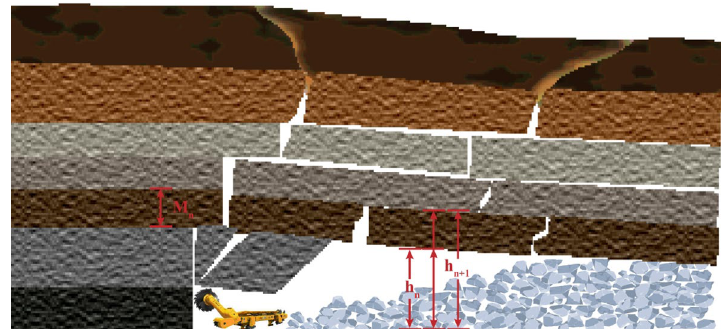
Figure 3. Diagram of overlying porosity (Adobe Illustrator CC 2018).